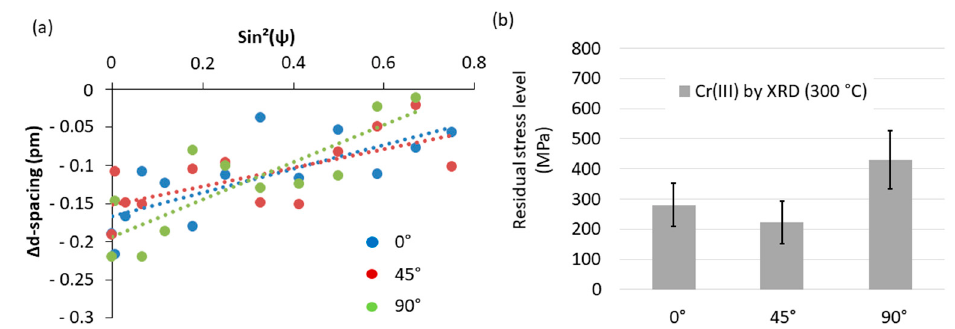
Figure 7. ( a ) Evolution of the Δ d spacing as a function of sin 2 ψ for the plane (211). A total of 0°, 45°, and 90° stands for the three different values of φ . ( b ) Results of the XRD residual stress level meas- urements on crystallized trivalent chromium.